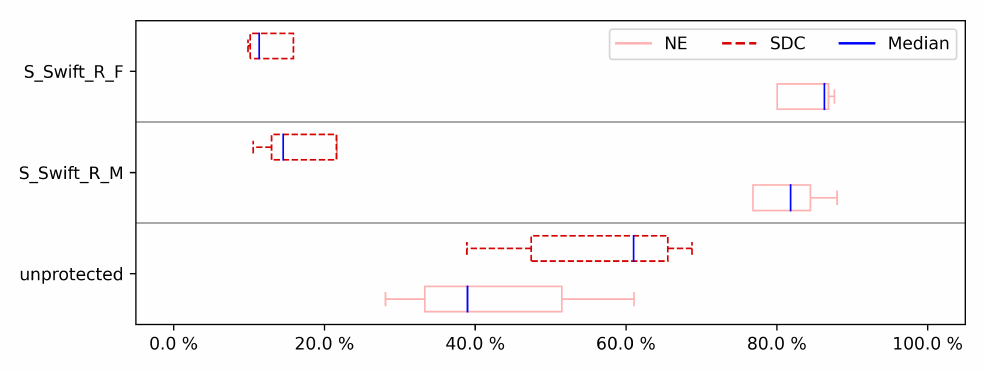
Figure 6. DFE fault injection results for 2 registers.